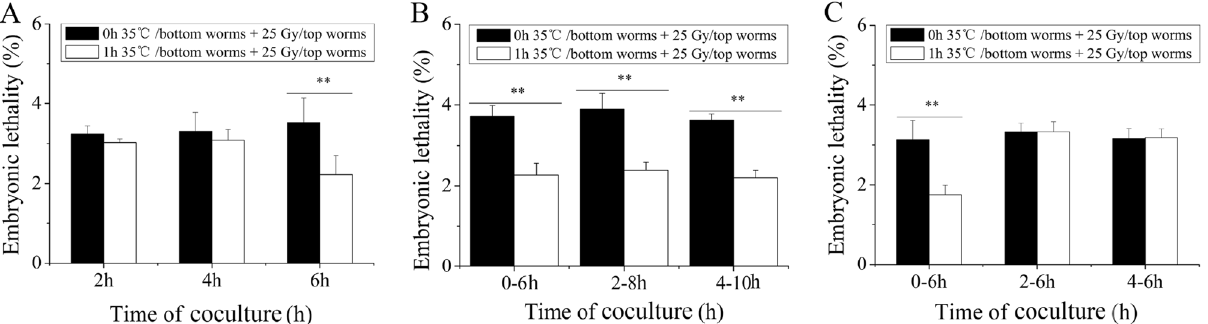
Figure 3. The induction of RAR in the top worms depends on the coculture time of the bottom heat-stressed worms. ( A ) Embryonic lethality of the top worms removed from the coculture system at the designated time point after coculture; ( B ) Embryonic lethality of the top worms moved into the coculture system for 6 h at the designated time point after the heat shock of bottom worms; ( C ) Embryonic lethality of the top worms